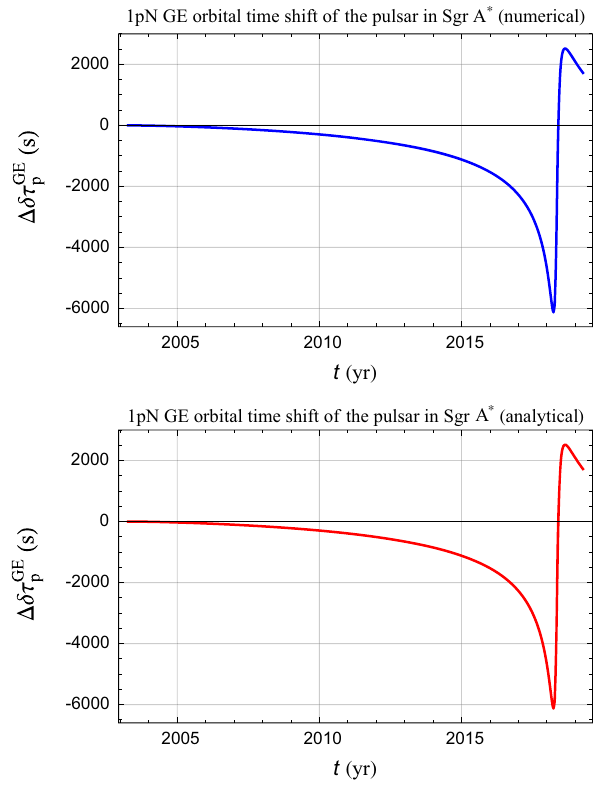
Fig. 1 Upper row , blue curve (cid:2)δτ GE p ( t ) , in s, of a hypothetical pulsar in Sgr A ∗ as the outcome of the difference between two numerical inte- grations of the equations of motion in Cartesian coordinates over a time span ranging from, say, t 0 = 2003 . 271 to t 0 + P b . Both the integrations have the same (Keplerian) initial conditions for f 0 = 139 . 72 ◦ , corre- sponding to t 0 = 2003 . 271, and differ by the 1pN Schwarzschild-like acceleration, which was purposely switched off in one of the two runs. Lower row , red curve (cid:2)δτ GE p ( t ) , in s, of a hypothetical pulsar in Sgr A ∗ obtained analytically from Eqs. (26) to (27) and the instantaneous changes of the Keplerian orbital elements, not displayed in the text, induced by Eq. (28). It turns out that the net shift after a full revolution (cid:4) (cid:3) = 1 , 722 . 6948 s. The (cid:2)δτ GE starting at t 0 = 2003 . 271 amounts to p orbital configuration of the S2 star, quoted in Table 1, was adopted for the putative pulsar in Sgr A